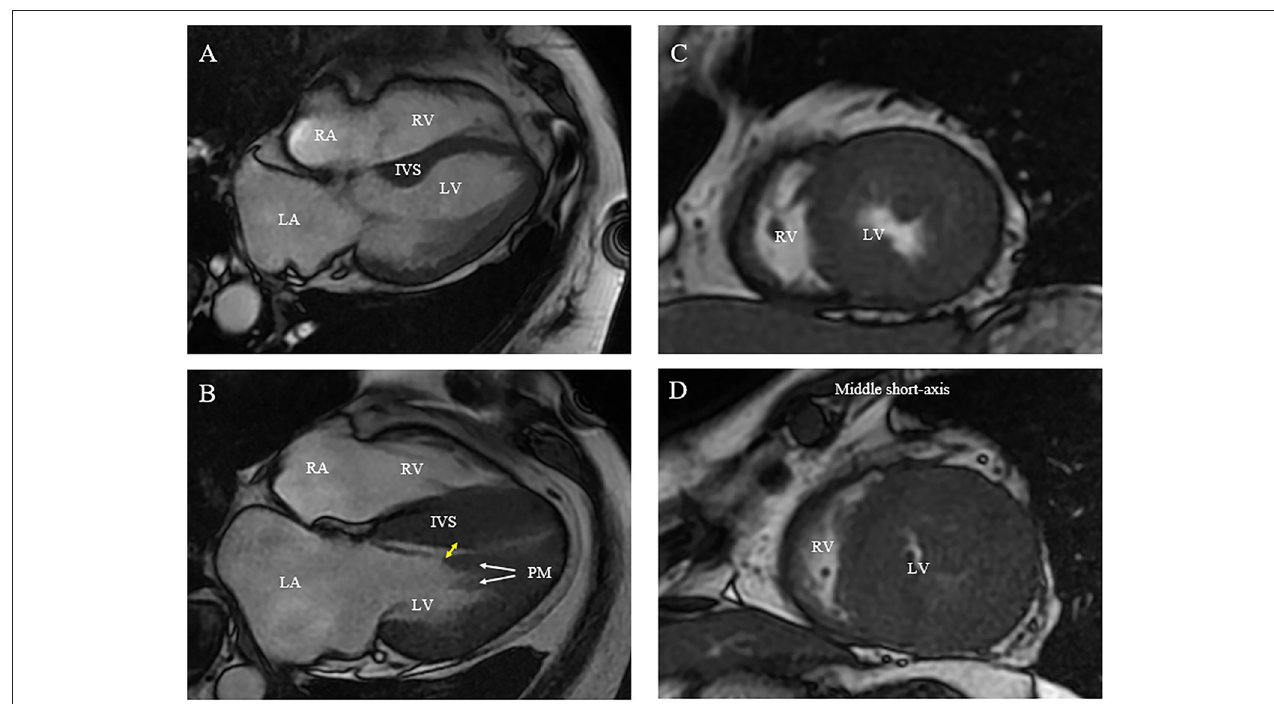
FIGURE 2 | Morphologic abnormalities of papillary muscle (PM) contributing to outflow tract obstruction [ (A) normal; (B) abnormal]. (A,B) On CMR, hypertrophied and apically displaced papillary muscle (white arrows) with superior head (yellow arrow) in close proximity to the bulged septum, positioning mitral valve plane toward ventricular septum compared with normal positioned PM (B) . (C,D) As compared with a relatively normal papillary muscle object (C) , CMR end-systolic image presents a severely narrowed LV cavity in patient with hypertrophied papillary muscle (D) .